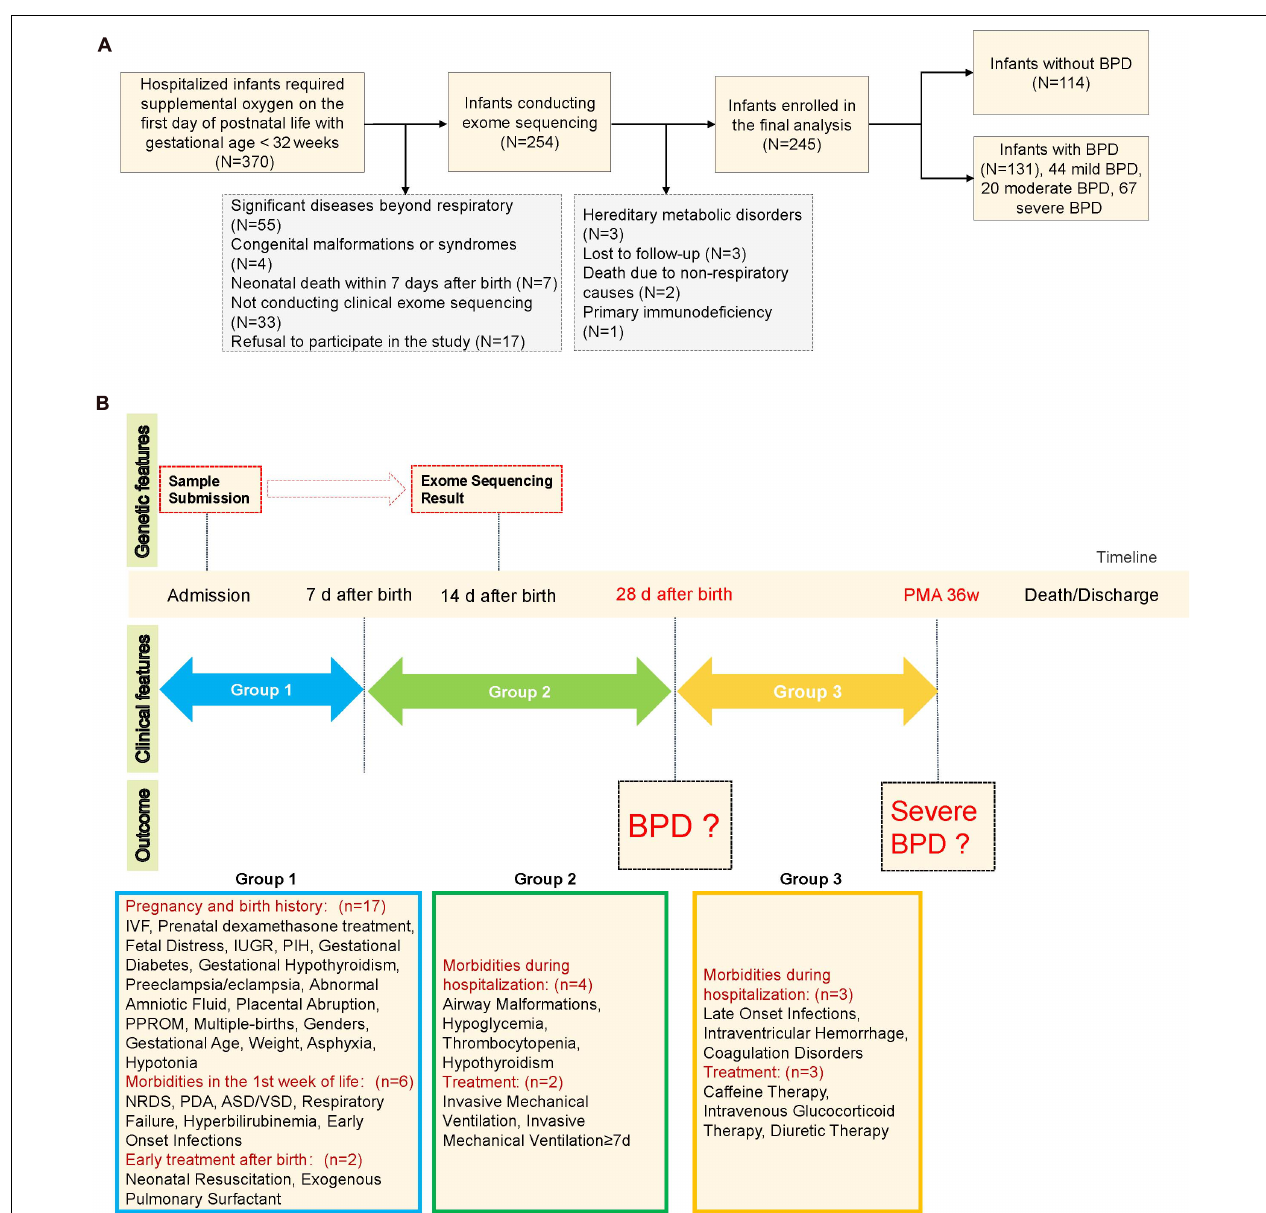
FIGURE 1 | Schematic diagram of the study design. (A) Study flow chart. (B) Schematic of clinical characteristic collection at each timepoint. Asphyxia was defined as APGAR score of less than seven at 1 min or/and APGAR score of less than seven at 5 min. IVF, in vitro fertilization; IUGR, intrauterine growth restriction; PIH, pregnancy-induced hypertension; PPROM, preterm premature rupture of membranes; NRDS, neonatal respiratory distress syndrome; ASD/VSD, atrial septal defect/ventricular septal defect. Patent ductus arteriosus was defined by clinical signs supported by echocardiographic confirmation. Airway malformations: bronchomalacia, tracheomalacia, laryngomalacia, or subglottic stenosis. Early-onset infections: prenatal infection within 72 h of delivery or onset of neonatal pneumonia/sepsis within 7 days of birth. Late-onset infections: infections after 7 days of birth. PMA 36w: postmenstrual age 36